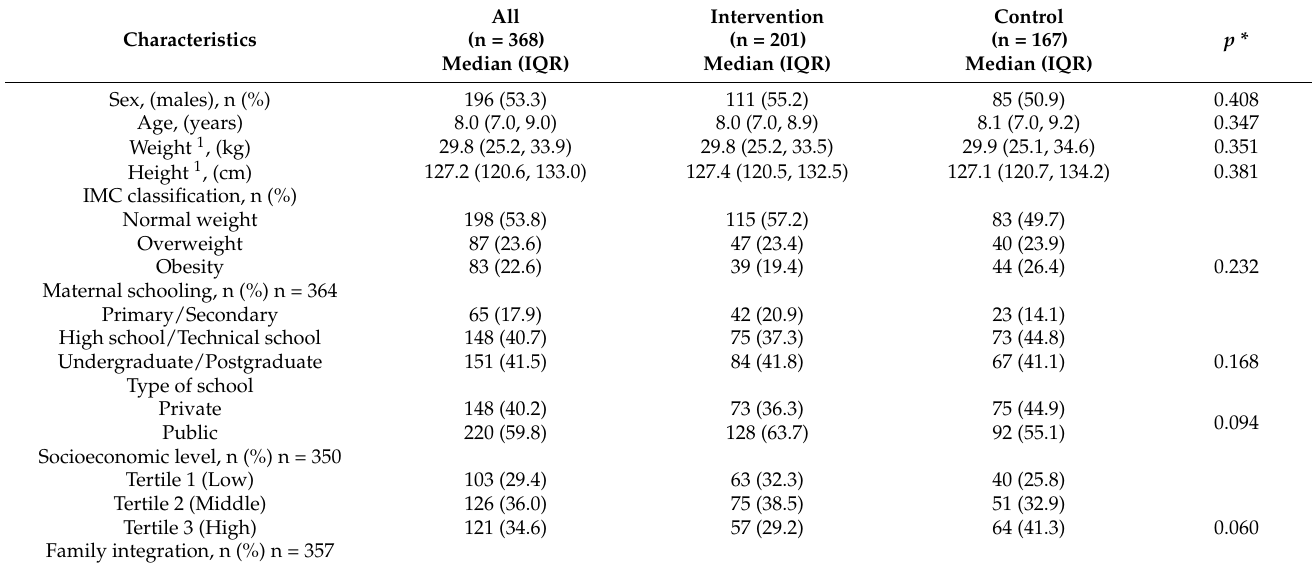
Table 1. General characteristics of the participants at baseline.